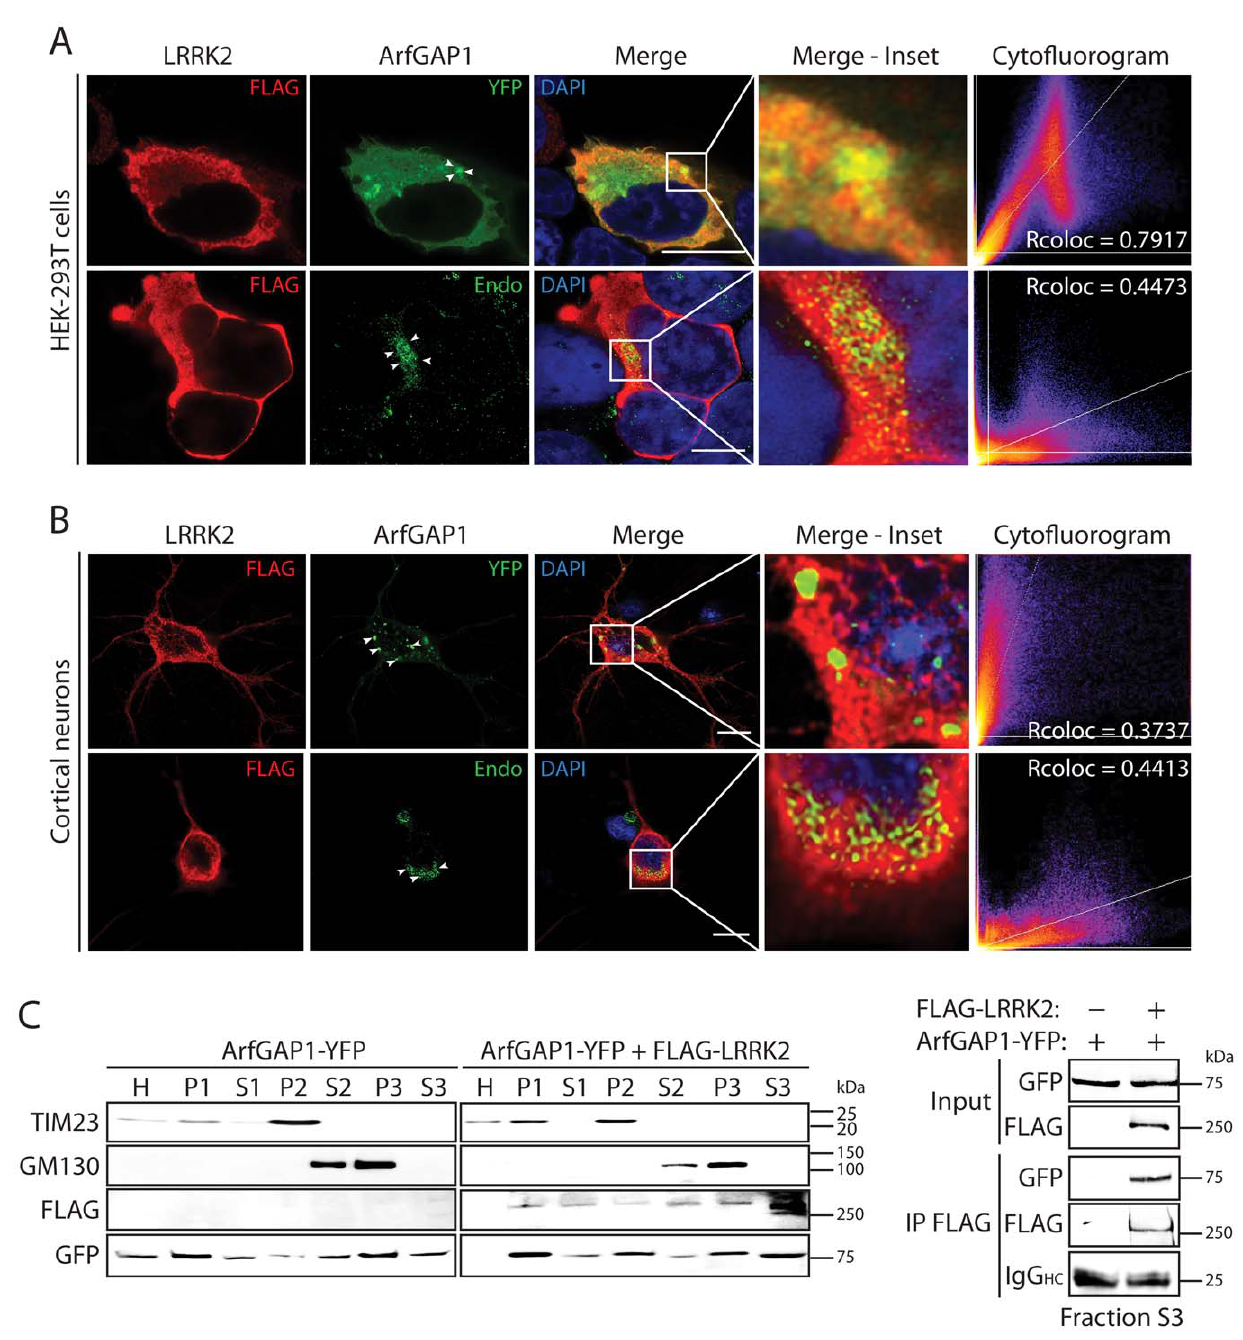
Figure 2. Co-localization of LRRK2 and ArfGAP1 in mammalian cells and neurons. (A) Confocal fluorescence microscopy reveals the co- localization of FLAG-tagged human LRRK2 with YFP-tagged and endogenous ArfGAP1 within the cytoplasm and at Golgi membranes of HEK-293T cells. ArfGAP1-YFP expression induces the dispersal of the Golgi complex and localizes to Golgi-derived vesicles and within the cytoplasm, whereas endogenous ArfGAP1 localizes to the intact Golgi complex ( arrowheads ) and at lower levels within the cytoplasm. Scale bars: 10 m m. (B) Similar co- localization of FLAG-LRRK2 with ArfGAP1-YFP or endogenous ArfGAP1 within the cytoplasm and at Golgi membranes ( arrowheads ) in rat primary cortical neurons. Cytofluorograms and co-localization coefficients (Rcoloc) reveal the extent of co-localization between LRRK2 and ArfGAP1 fluorescence signals with strongest correlation between LRRK2 and ArfGAP1-YFP in HEK-293T cells, and LRRK2 and endogenous ArfGAP1 in cortical neurons. Confocal images are taken from single z-plane at 0.1 m m thickness. Images are representative of at least three independent transfection experiments. Scale bars: 10 m m. (C) Subcellular fractionation of HEK-293T cells expressing ArfGAP1-YFP and FLAG-LRRK2. LRRK2 and ArfGAP1 are detected together in multiple subcellular fractions including soluble cytosolic (S1-S3), heavy (P2, mitochondria/TIM23) and light (P3, Golgi/GM130) membrane fractions ( left panels ). ArfGAP1-YFP interacts with FLAG-LRRK2 in the membrane-deficient soluble cytosolic fraction (S3) following IP with anti-FLAG antibody ( right panel ). Molecular mass markers are indicated in kilodalton (kDa). Blots are representative of at least two independent experiments.